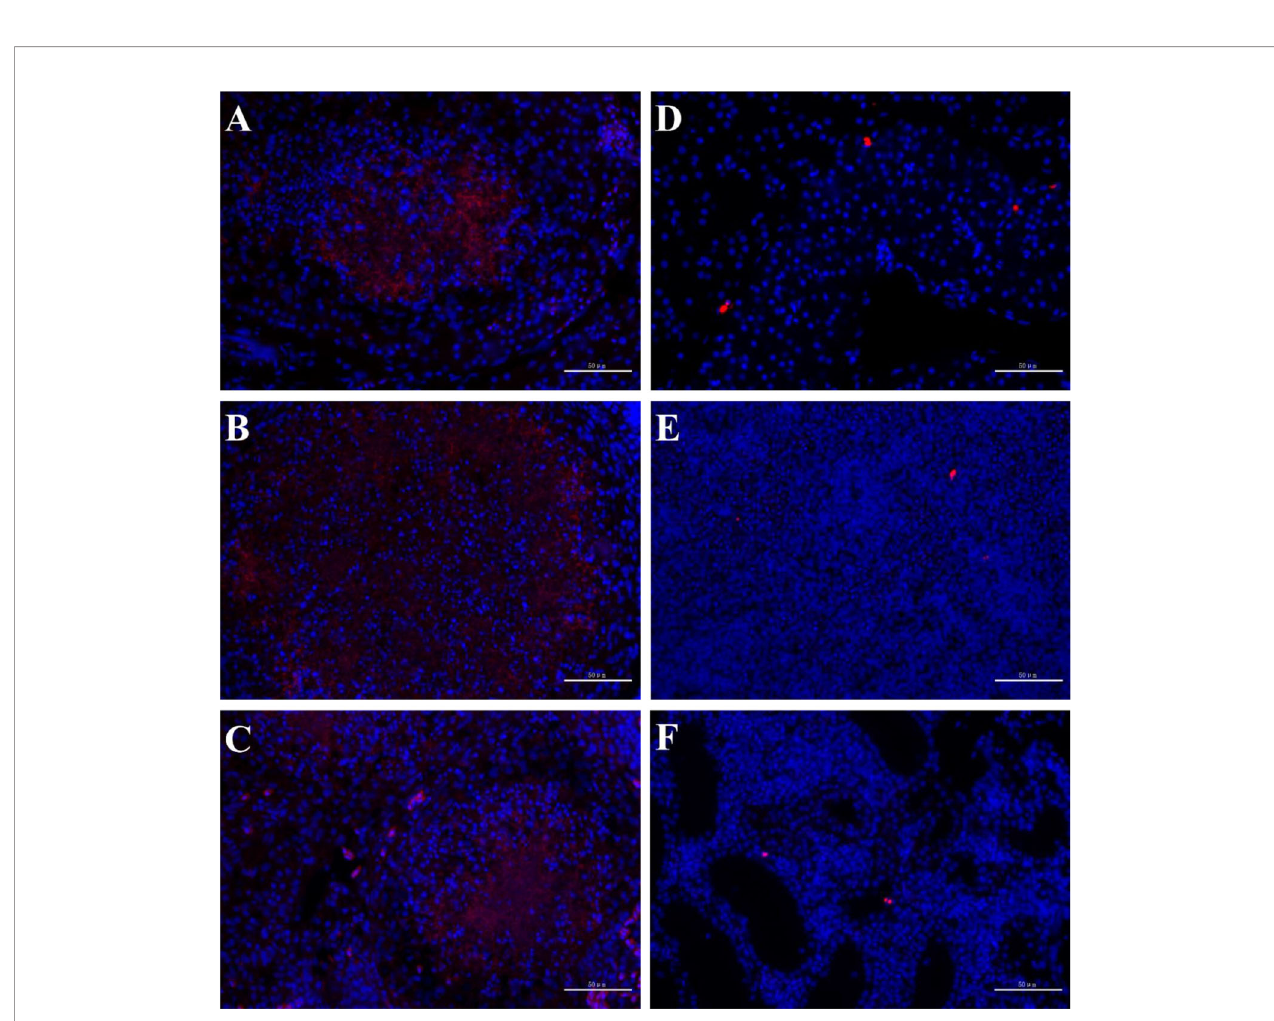
FIGURE 3 | FISH of hybrid snakehead. The probe had strong hybridization signals in the liver (A) , spleen (B) and kidney (C) of diseased fi sh, but weak hybridization signals in the liver (D) , spleen (E) and kidney (F) of healthy fi sh. Scale bar = 50 mm.